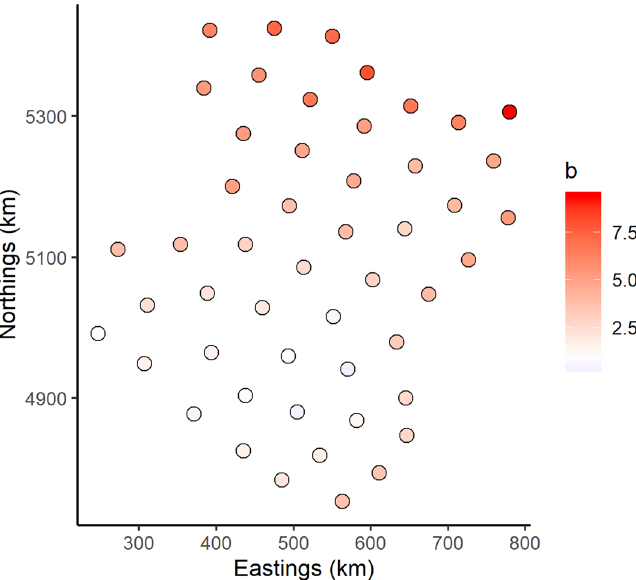
Figure 3. The estimate of the slope (exponent) between local and total biomass (b k ) from the knot specific exponential models comparing yellowtail flounder local density based on total biomass across the fifty knots in the VAST. Red circles represent a b k > 1 which indicate large local biomass changes with total biomass changes (i.e. marginal habitat), white circles represent a b k = 1, and blue circles represent a b k < 1 which indicate that